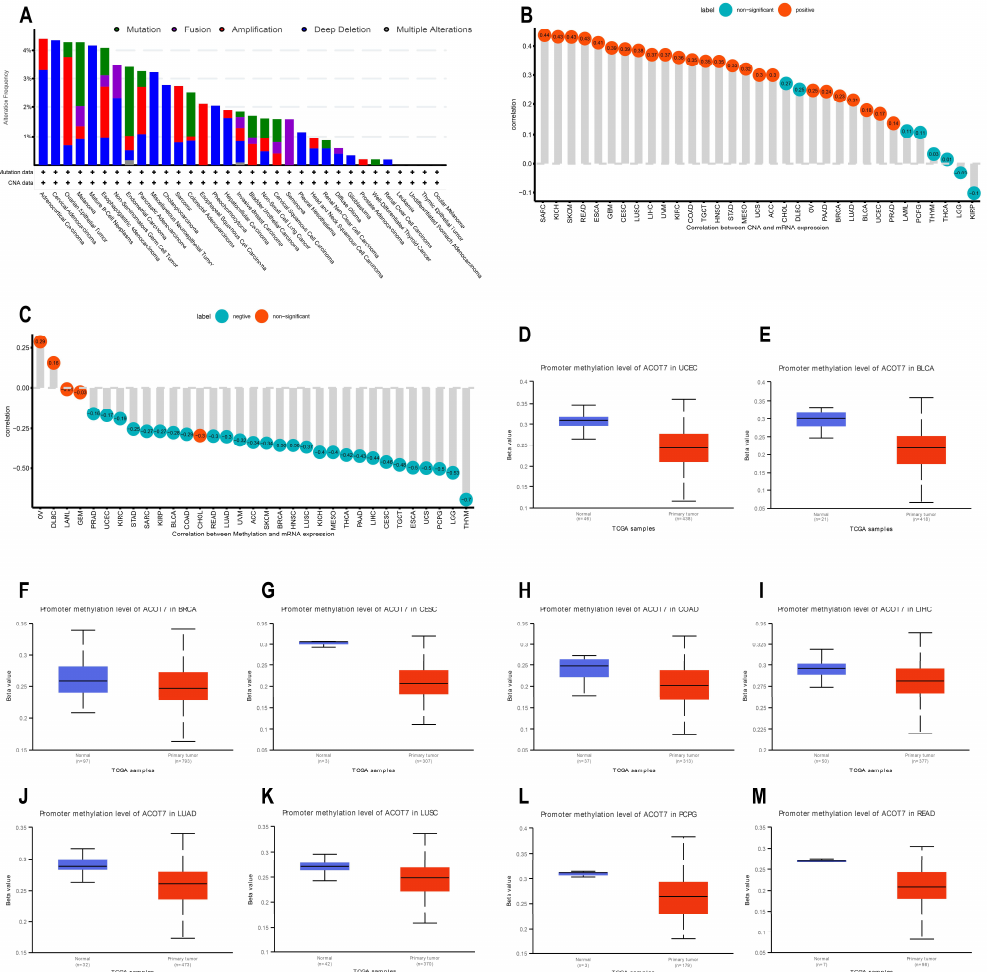
Figure 4. Genetic alteration analyses of ACOT7. ( A ) CNA and mutation frequency data of ACOT7 from cBioPortol dataset; ( B ) Pearson’s correlation between ACOT7 expression and CNA from TCGA dataset; ( C ) Pearson’s correlation between ACOT7 mRNA expression and DNA methylation from TCGA dataset; ( D – M ) comparison of promoter DNA methylation status of ACOT7 between cancer and adjacent normal tissues in ( D ) UCEC, ( E )BLCA, ( F ) BRCA, ( G ) CESC, ( H ) COAD, ( I ) LIHC, ( J ) LUAD, ( K ) LUSC, ( L ) PCPG, and ( M ) READ. Abbreviations: ACOT7, Acyl-CoA thioesterase 7; LUAD, lung adenocarcinoma; CNA, copy number